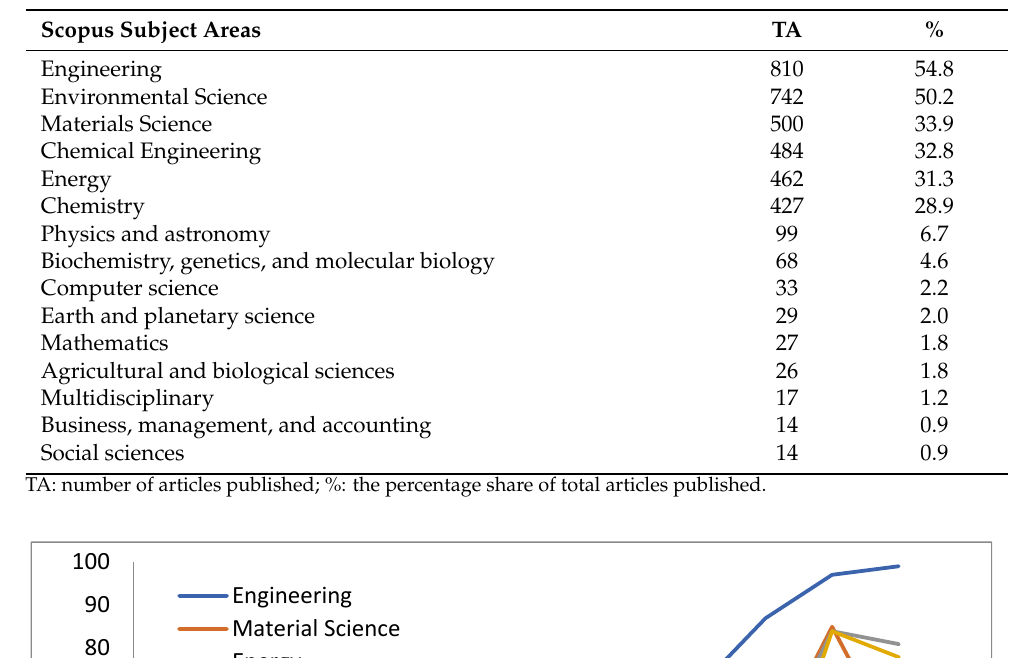
Table 2. The 15 most productive subject areas and published articles.